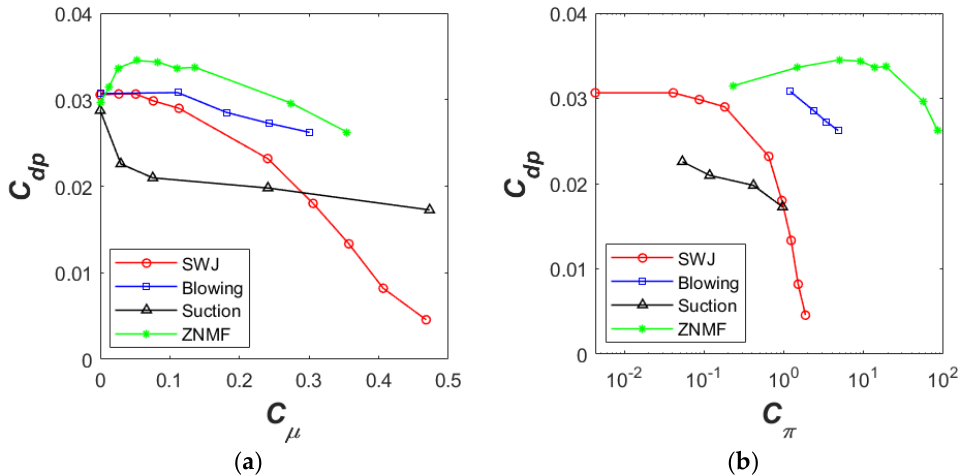
Figure 14. The variation of the pressure drag coefficient for different AFC methods with respect to: ( a ) momentum coefficient; ( b ) power coefficient.